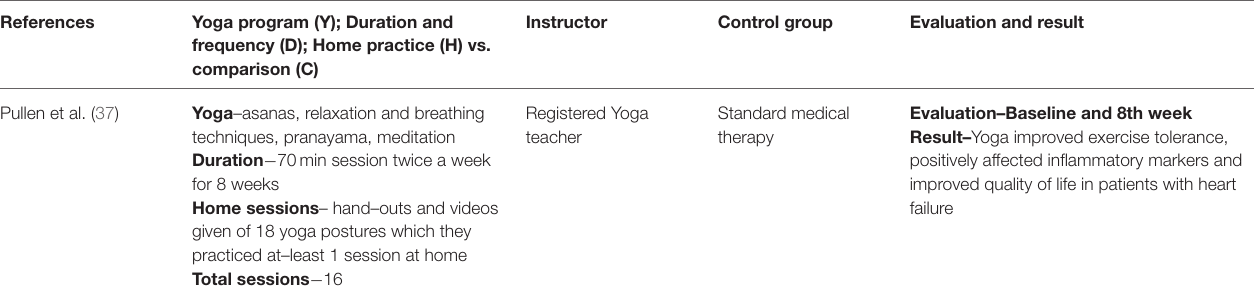
TABLE 3 | Risk of bias assessment using the cochrane risk of bias tool.